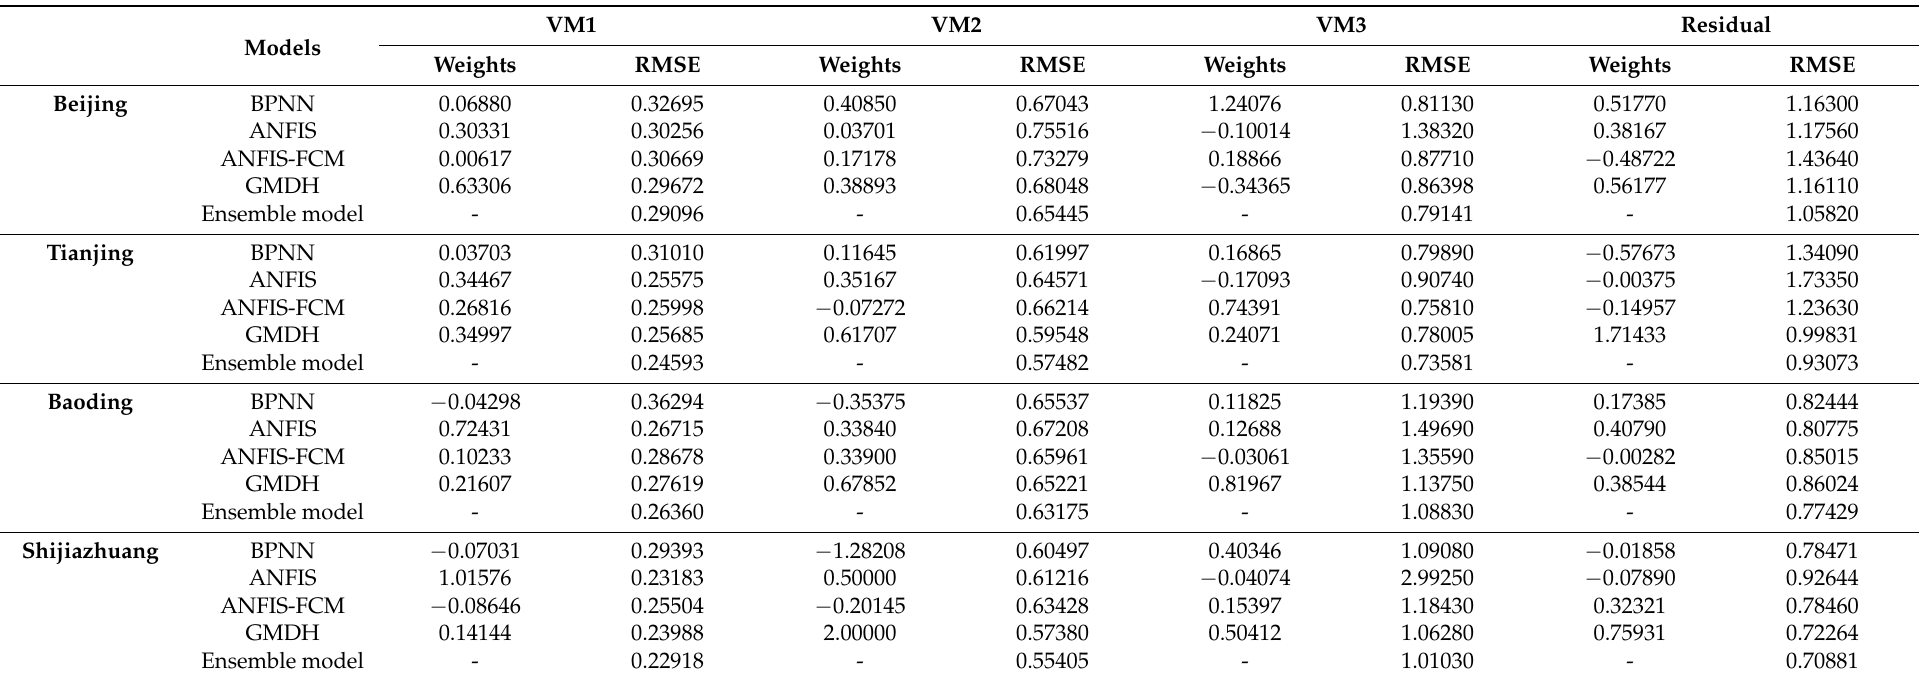
Table 3. VMs forecasting results of the individual model and ensemble models in four